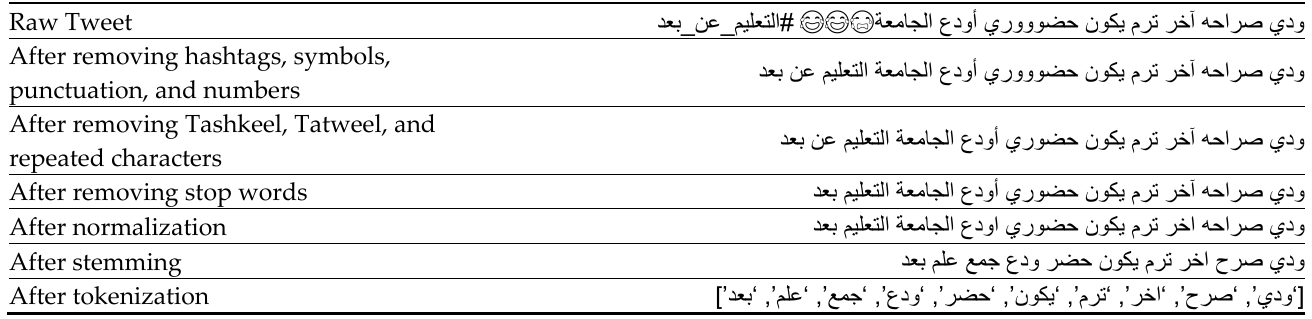
steps applied in this research. Table 4. Example of implementing the pre-processing steps on a tweet. Table 4. Example of implementing the pre-processing steps on a tweet . Table 4. Example of implementing the pre-processing steps on a tweet .